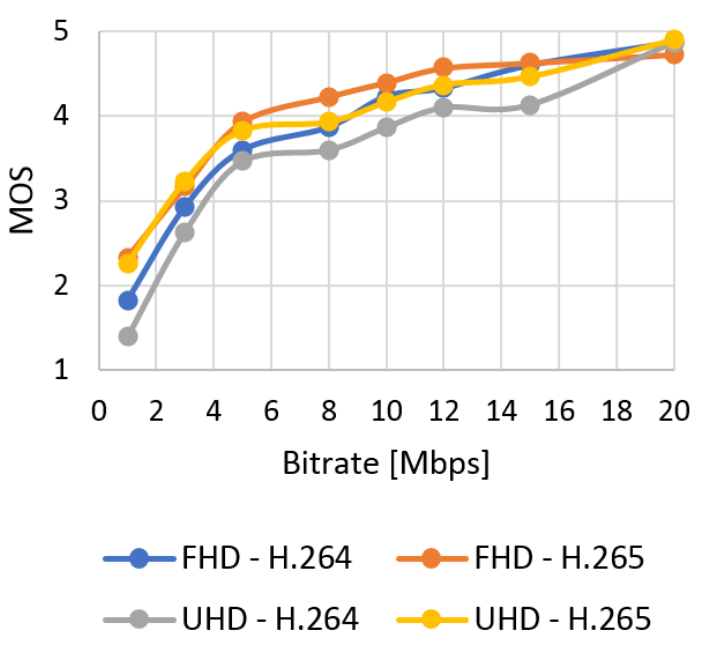
Figure 12. Bund Nightscape, subjective evaluation.